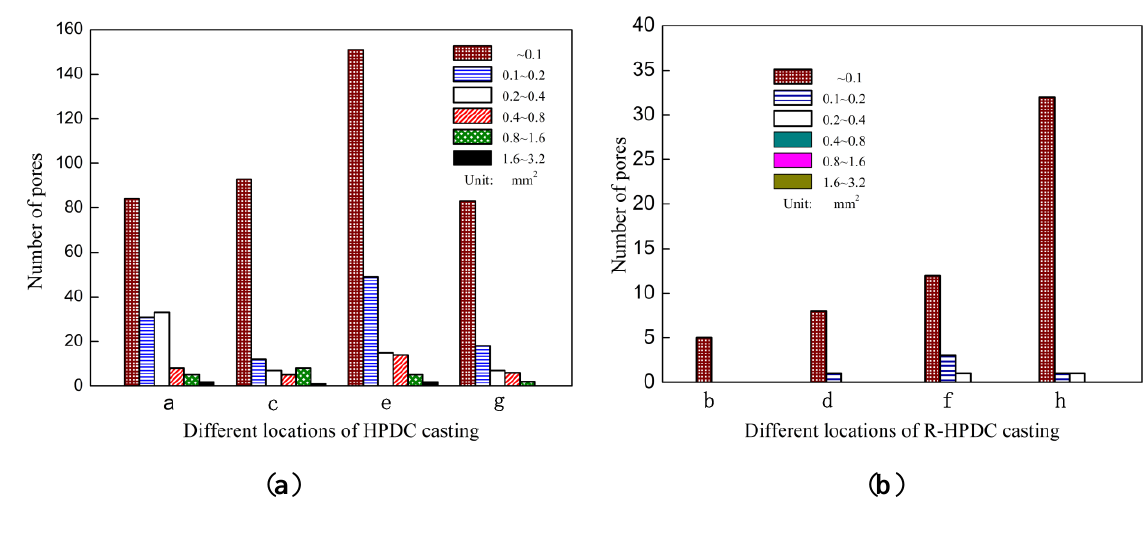
Figure 4. Number of pores in different locations of A380 parts by ( a ) HPDC and ( b ) R-HPDC